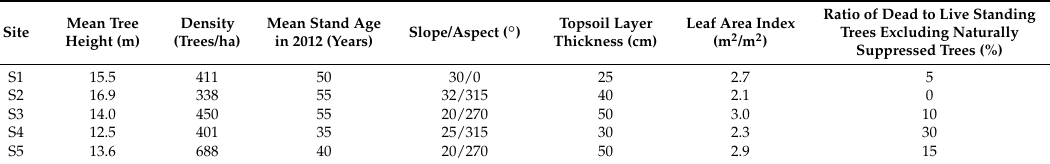
Table 1. Site and stand characteristics of the analysed